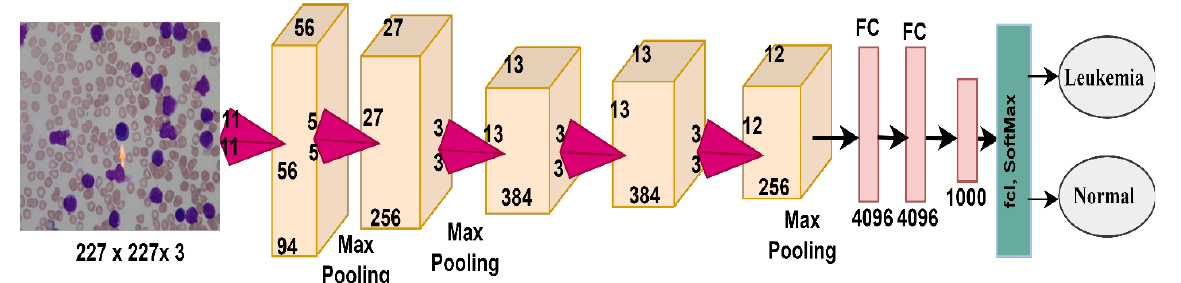
Figure 8. AlexNet network structure for ALL-IDB dataset diagnostics.